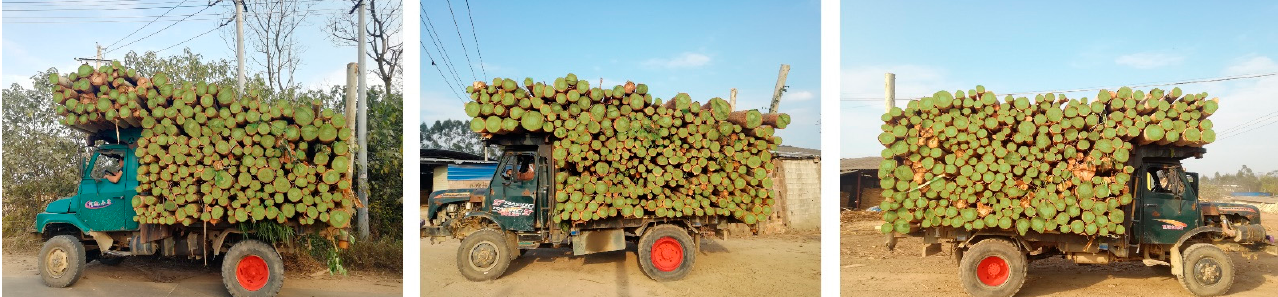
Figure 5. Segmentation results of the model in real-world scenarios, where the red circle indicates the selection of diameter on the back wheel of a truck as a ruler. Table 4. Model Performance Comparison. Model Mean Relative Error/% Standard Deviation/%